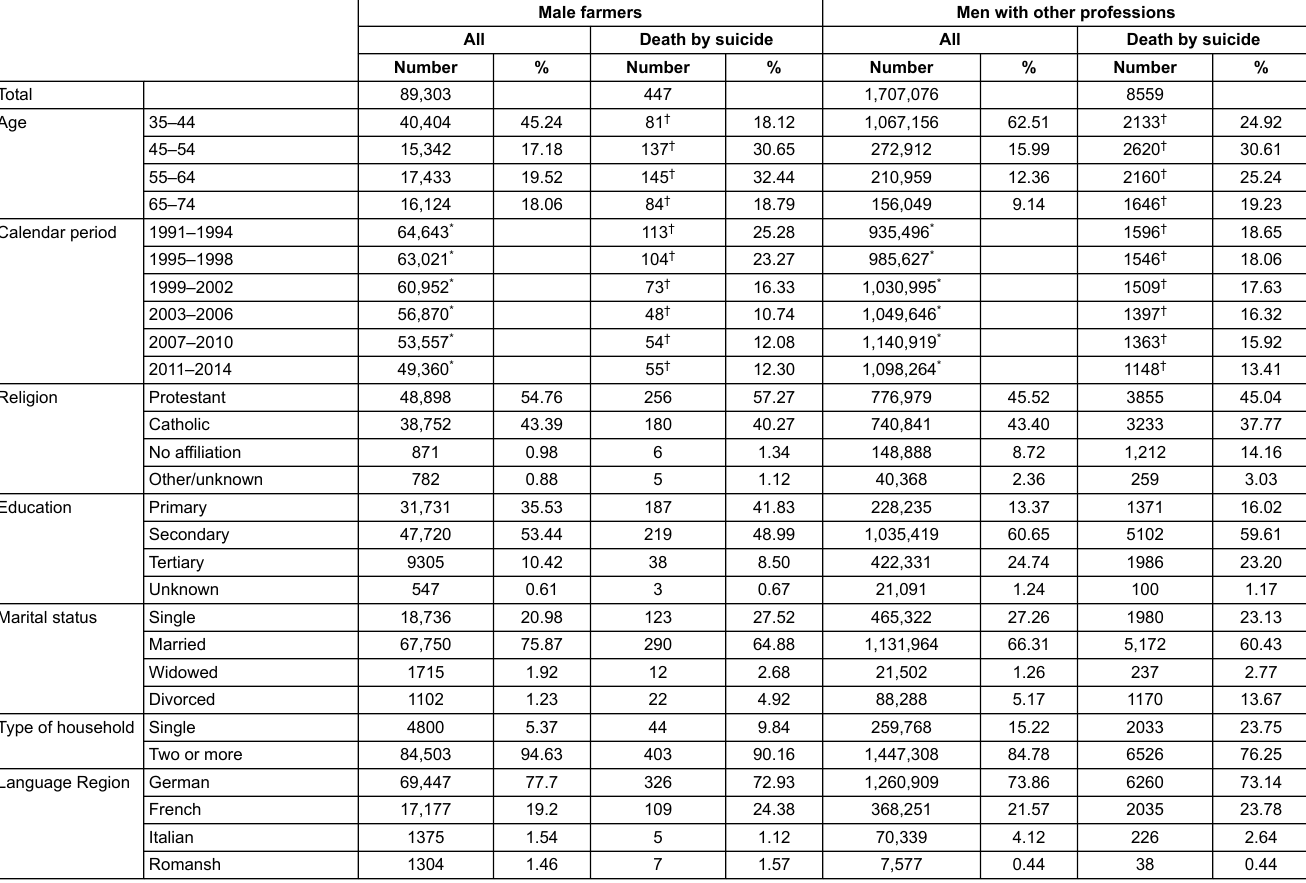
Table 1: Characteristics of male farmers and the male population with other professions at study entry, and the number of suicides.